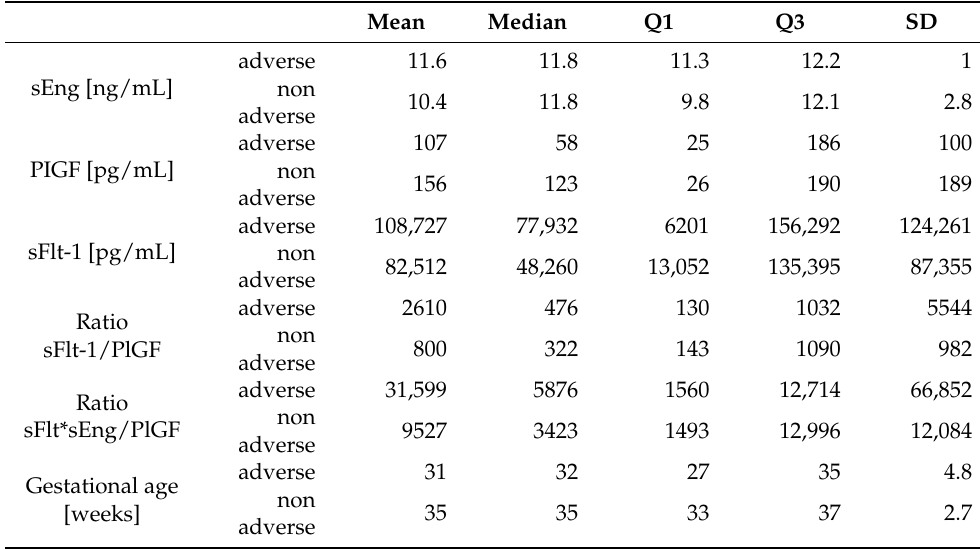
Table 8. Distributions of the values of sFlt-1, sEng, PlGF and the sFlt-1/PlGF and sFlt-1*sEng/PlGF ratios in pregnancies with and without adverse